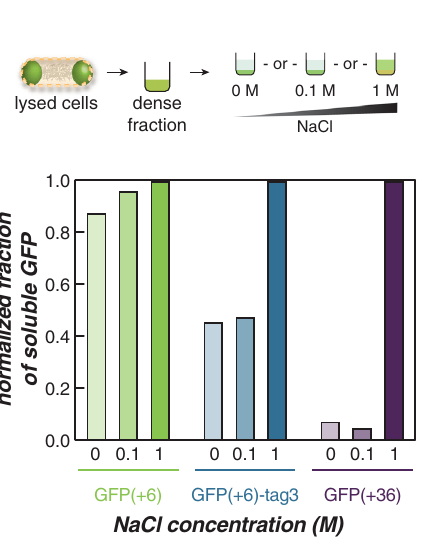
Fig. 4 | In vitro characterization of GFP(+6)-tag3/RNA coacervates. a The sche- matic (top) summarizes the solubility of GFP(+6)-tag3 intracellular condensates in buffers of increasing ionic strength. Similar to the highly supercharged, condensate-forming variant — GFP(+36) — GFP(+6)-tag3 was extracted from con- densatesexvivobyincreasingNaClconcentration,whileavariant,GFP(+6)thatdid notformcondensatesatthistimedidnotshowpreferentialextractionasafunction of salt concentration (bottom). Scheme adapted with permission from ACS Cent. Sci . 2020 , 6 (12), 2301 – 2310. Copyright 2020 American Chemical Society. b Turbidimetrymeasurements of GFP(+6)-tag3 with total RNAfrom torulayeast at 1mg/mltotalmacromoleculeconcentration.Datapointsrepresenttheaverageand